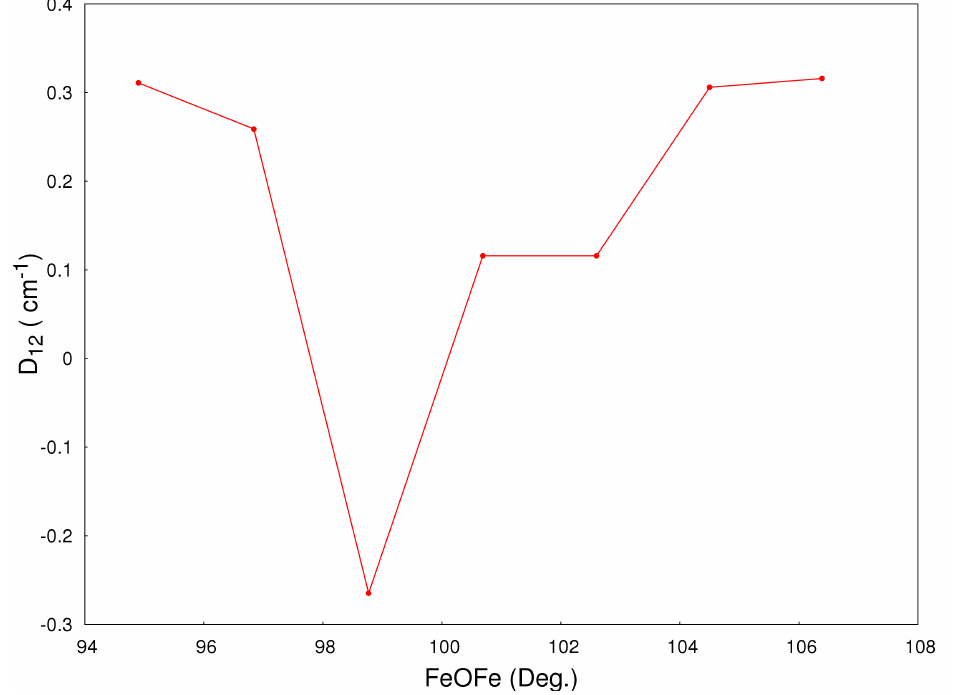
Figure 5. Magneto-structural correlation plot for D 12 (cm − 1 ) as function of the FeOFe angle